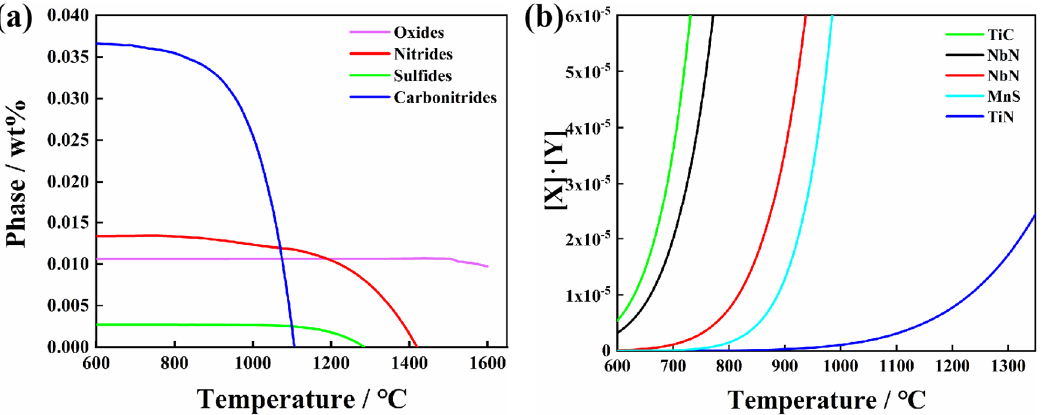
Table 3. The solubility expressions for the precipitations [63,64].